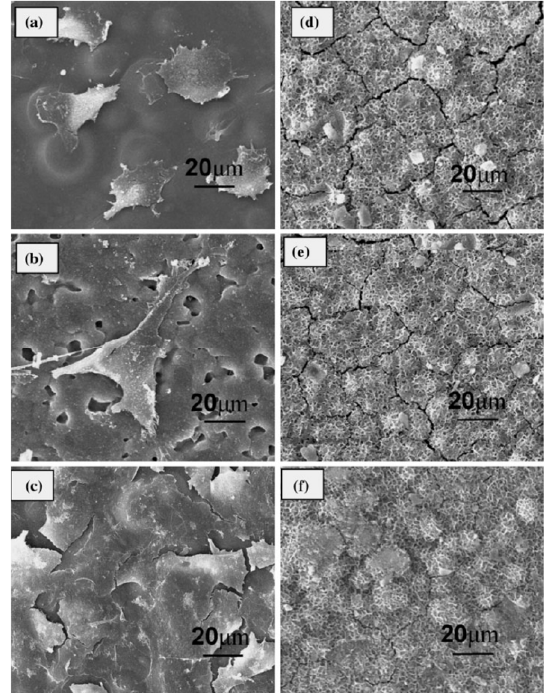
Figure 37. SEM micrographs of cell morphology after various culture times on polylactic-co-glycolic acid (PLGA) coated Mg alloys after ( a ) 1 day; ( b ) 2 days and ( c ) 3 days culture and uncoated PLGA after ( d ) 1 day; ( e ) 2 days and ( f ) 3 days culture. Reprinted with permission from [173], Springer, 2010.